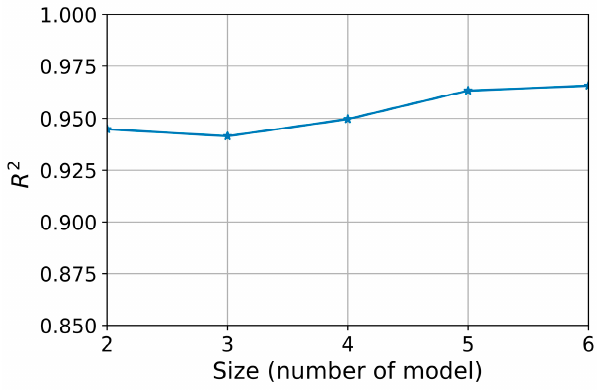
Figure 6. Effect of the number of sub-models.